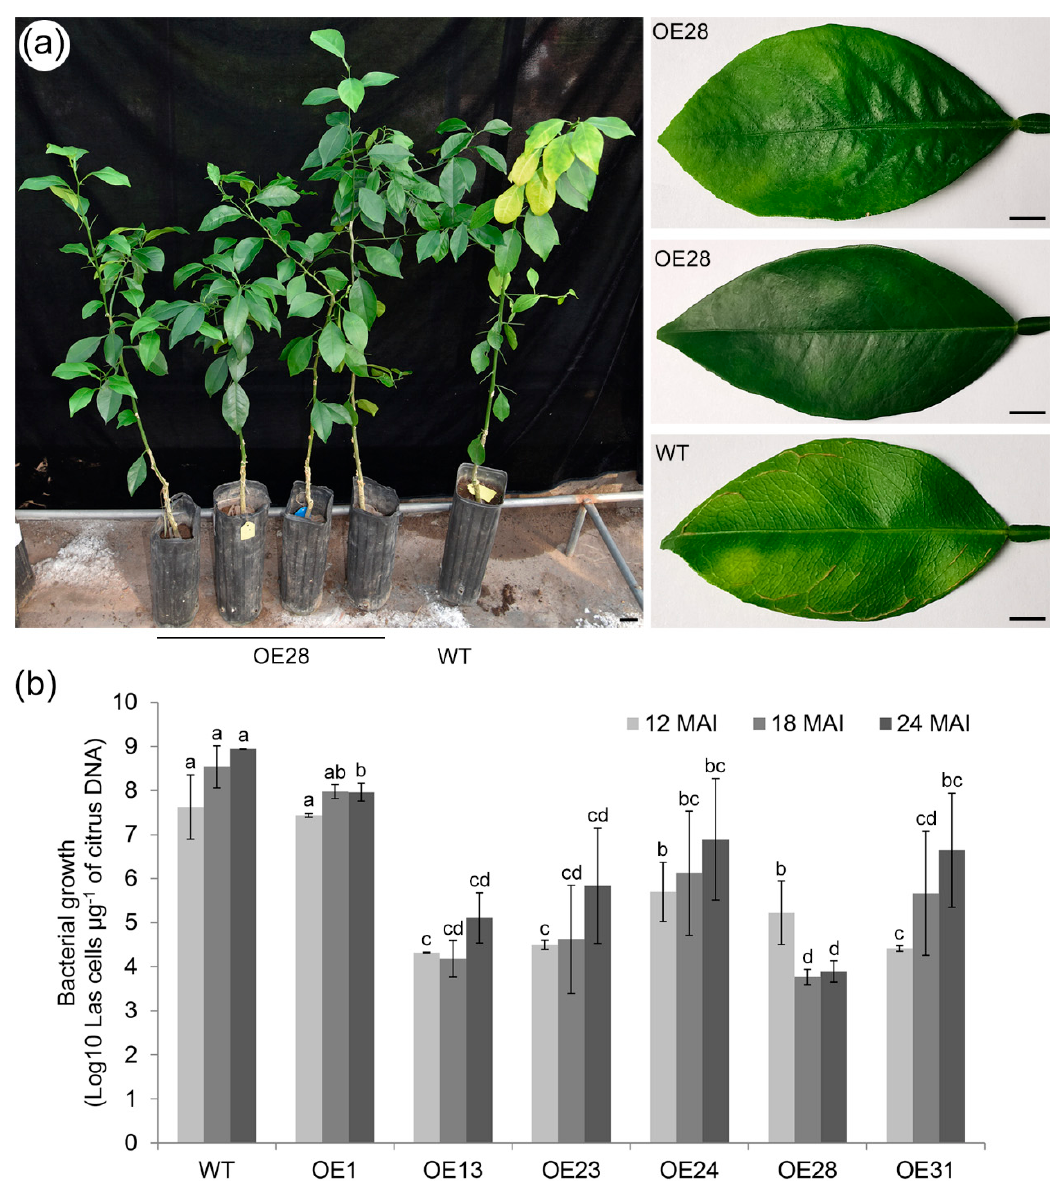
Figure 3. Evaluation of Citrus Huanglongbing (HLB) tolerance in transgenic citrus plants grown in a greenhouse. ( a ) HLB symptoms in the transgenic plants and a wild type (WT) control 12 months after infection (MAI). ( b ) Quantitative analysis of Las bacterial growth at 12, 18 and 24 MAI. The bacterial populations (Las cells µ g − 1 of citrus DNA) were investigated using qPCR. Standard errors were calculated from three or four plants per line. Different letters on the top of the bars indicate significant differences from the WT control based on a Tukey’s test ( p < 0.05). WT, wild type; OE#, transgenic plants. Bar = 1 cm.